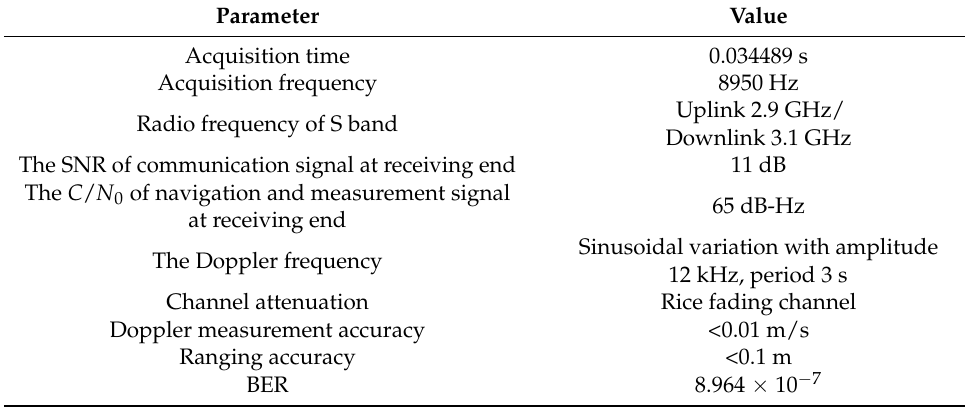
Figure 17. The hardware test environment. ( a ) The test environment, and ( b ) the hardware picture. Table 2. The hardware test